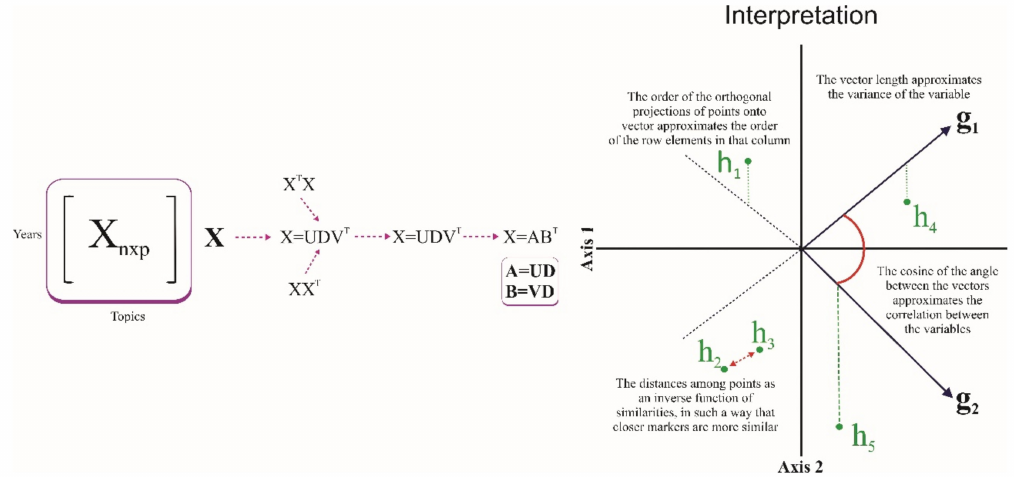
Figure 2. Description the HJ-Biplot